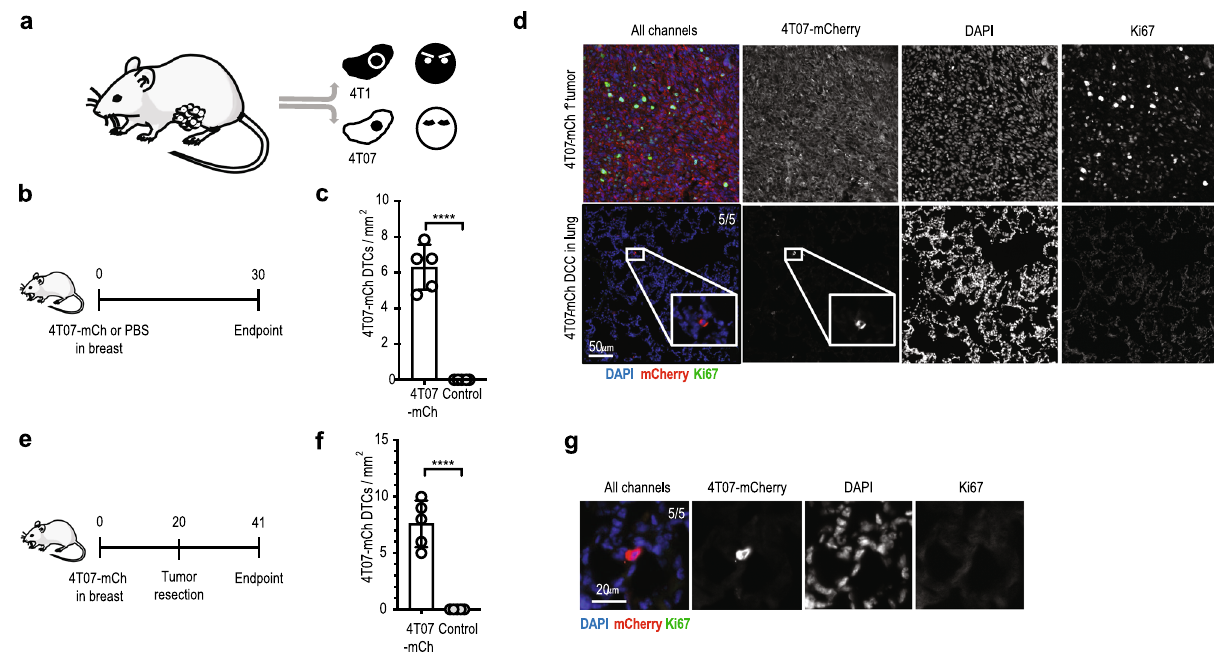
Fig. 1 4T07 but not 4T1 breast cancer cells are dormant after dissemination to the lungs. a Diagram of the origin of 4T1 and 4T07 cell lines 21 . b Experimental design. 4T07-mCh cells (10 5 ) or PBS were injected into the mammary fat pad of female BALB/c mice. Analysis was performed 30 d later. c Quanti fi cation of disseminated 4T07-mCh cells by quantitative pathology, **** p < 0.0001. d 4T07-mCh cells (10 5 ) were injected into the mammary fat pad of female BALB/c mice. Analysis was performed 35 d later. Representative section of the primary tumor (upper panels) and lung (lower panels) at the endpoint. Disseminated 4T07-mCh cells were detected as single, Ki67-negative cells in the lungs of 5 out of 5 mice. Disseminated 4T07-mCh cells are shown in red, Ki67 in green, DAPI in blue. Scale bar indicates 50 µ m. e Experimental design. 4T07-mCh cells (10 5 ) were injected into the mammary fat pad of female BALB/c mice. The tumor was resected 20 d after injection and analysis was performed 21 d after resection (endpoint). f Quanti fi cation of disseminated 4T07-mCh cells by quantitative pathology. **** p < 0.0001. g Representative section of the lung at the endpoint. Disseminated 4T07-mCh cells were detected as single, Ki67-negative cells in the lungs of 5 out of 5 mice. Disseminated 4T07-mCh cells are shown in red, Ki67 in green, DAPI in blue. Scale bar indicates 20 µ m. Each symbol represents an individual mouse. Five mice per group. 2-tailed Student ’ s t -test. The bar represents the mean ± SD. Results are representative of three independent